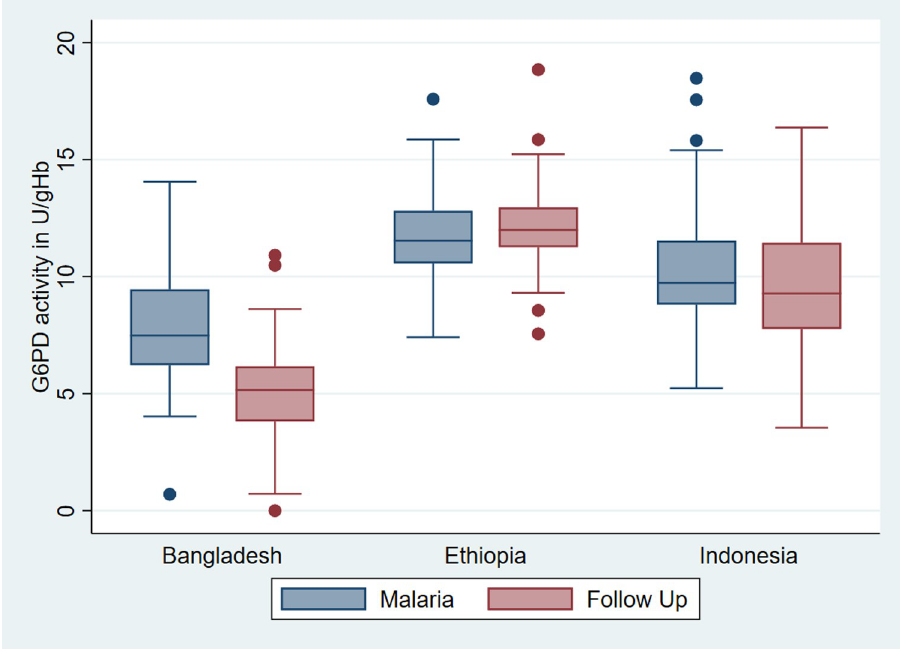
Fig 2. Box and Whiskers plot of median normalized G6PD activity during malaria and follow up per study site among selected participants.